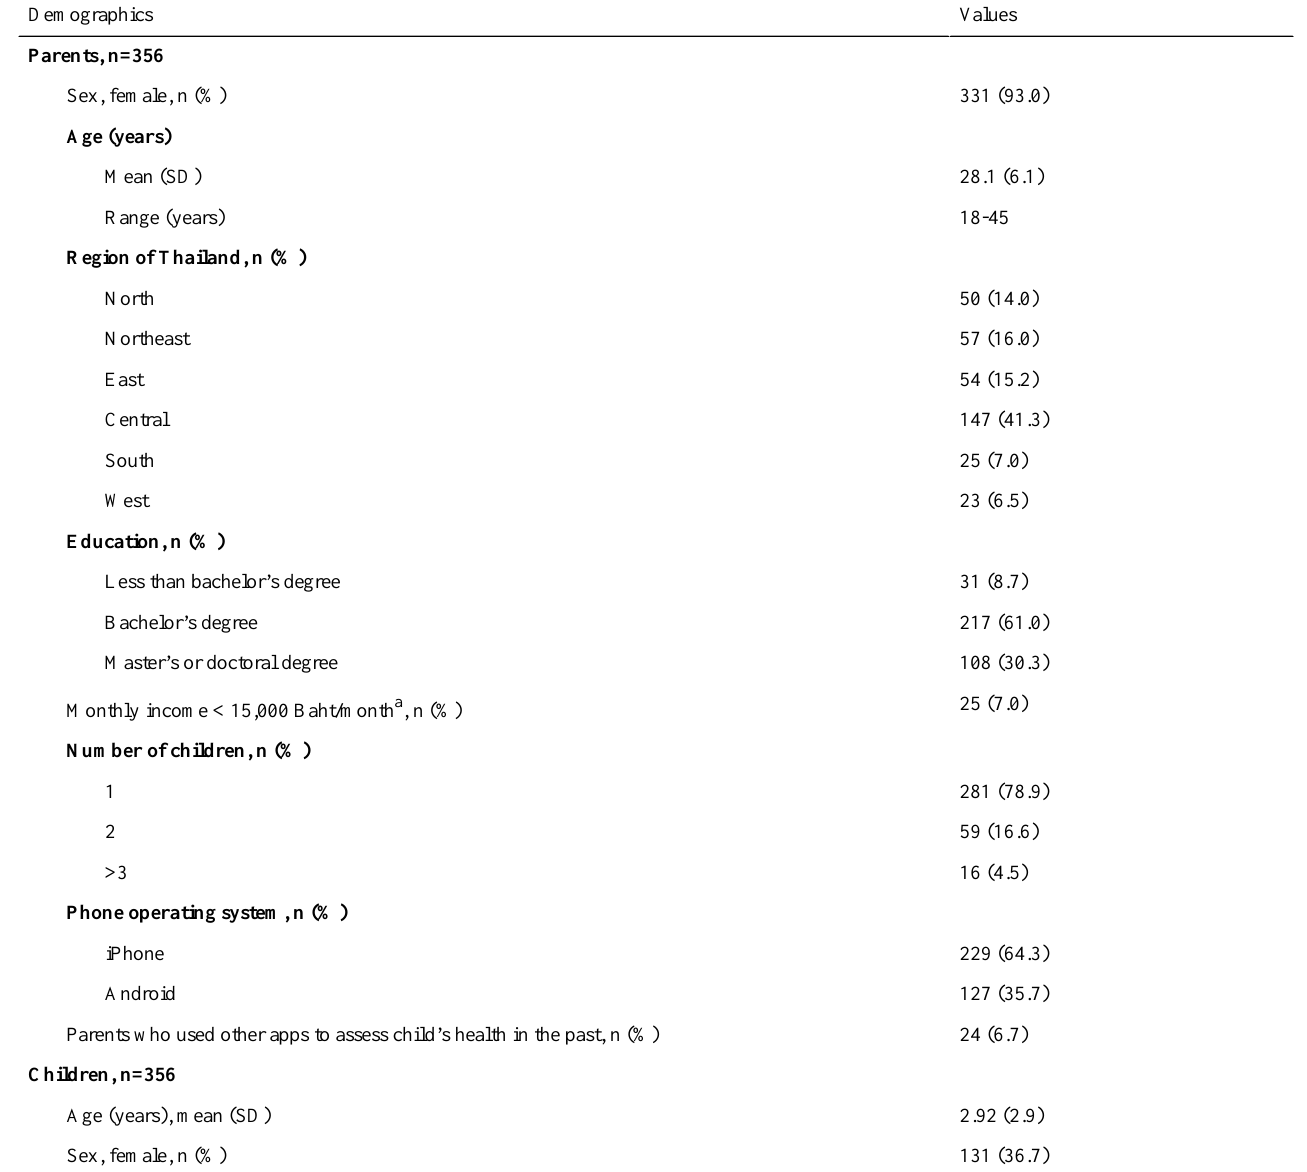
Table 4. Baseline characteristics of the parents and children in the web-based survey